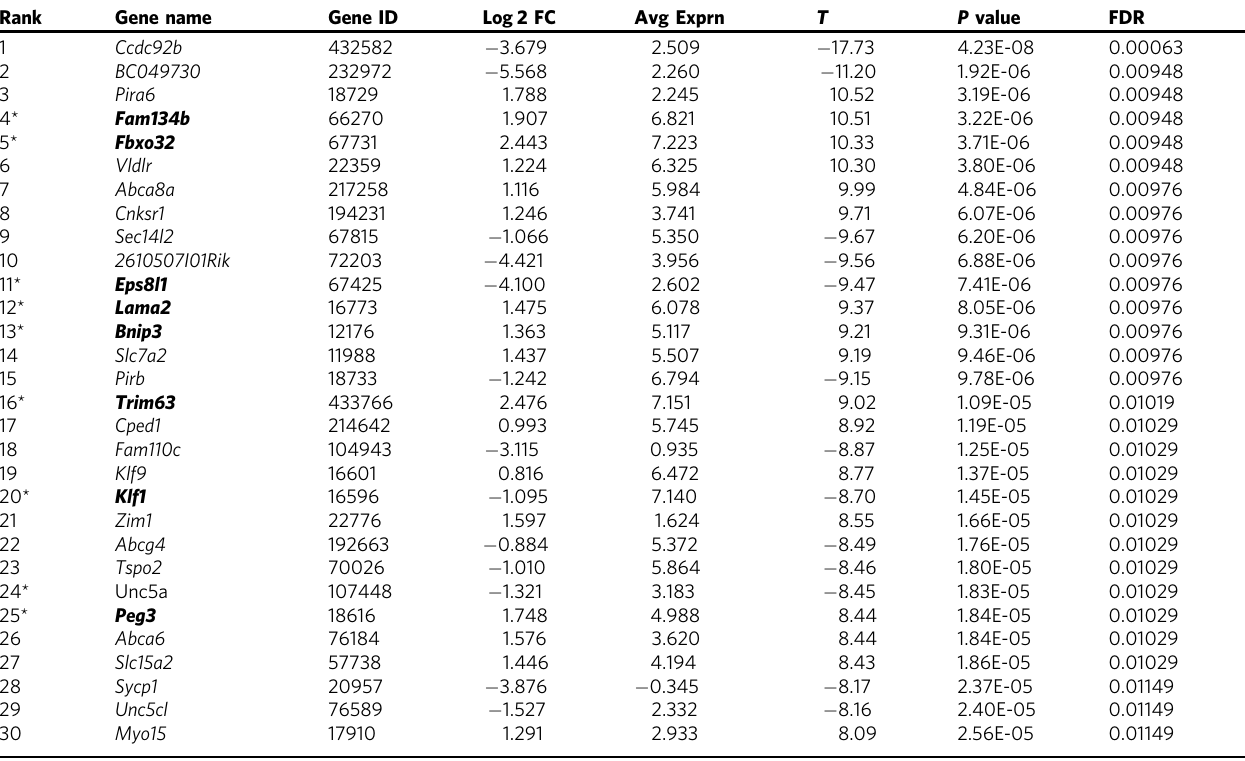
Table 1 Upregulation of autophagy-related genes by RNA-sequencing of Dmp1Cre.Efnb2 f/f bone